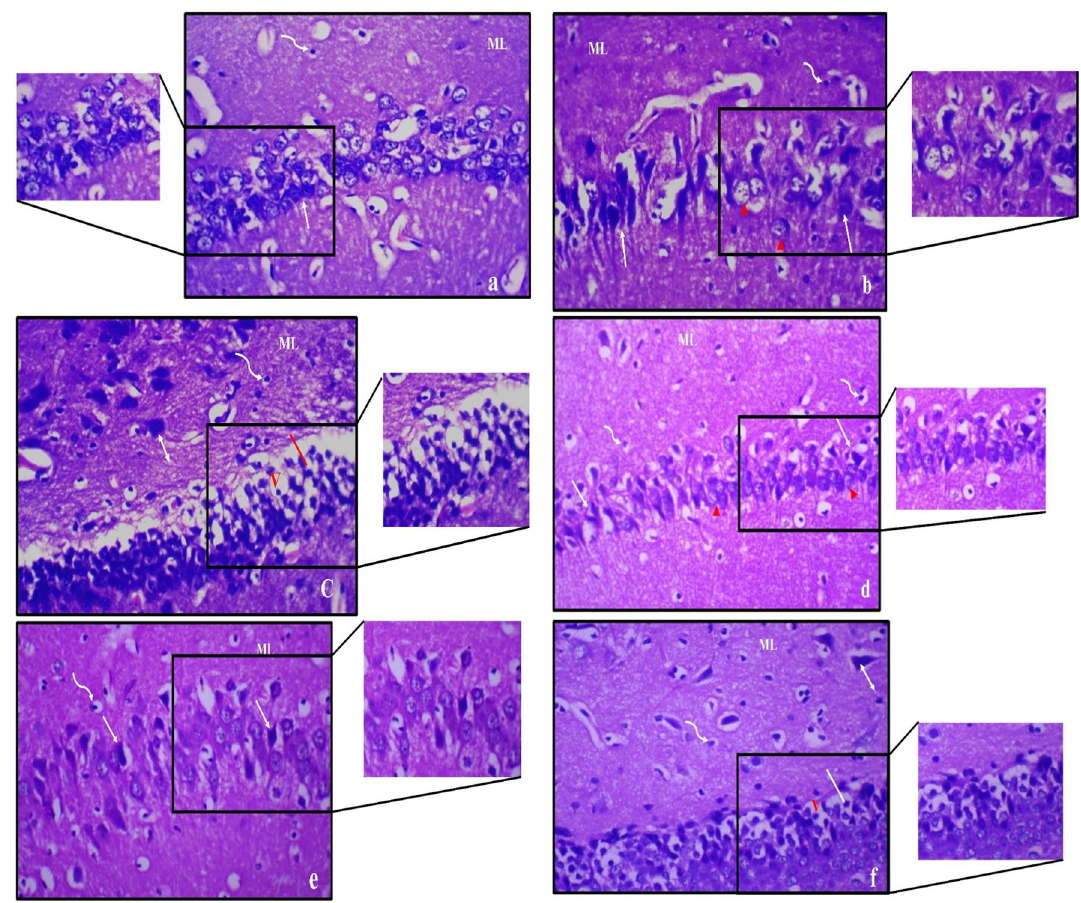
Figure 8. Photomicrograph of haematoxylin and eosin-stained sections from hippocampus of obese male rat ( a – c ) and obese female rats ( d – f ) treated with 15 mg of zinc showing partial improvement, where; ( a ) preservation of small pyramidal neurons with many apoptotic cells ( ↑ ); ( b ) marked apoptosis of large pyramidal neurons ( ↑ ) with few normal cells (right pointing triangle) and ( c ) decreased population of granular cells (|) with marked disorganization and vacuolation (V). Molecular layer (ML) mostly shows marked enlargement of neurons ( ↕ ) and many glial cells (wavy arrow); ( d ) preservation of small pyramidal cells (right pointing triangle) with many apoptotic cells ( ↑ ); ( e ) marked apoptosis of some large pyramidal cells ( ↑ ) and (f) d ecreased population of granular cells (|) with marked disorganization with less vacuolation (V). Molecular layer (ML) mostly shows marked enlargement of many neurons ( ↕ ) and many glial cells (wavy arrow) (H & E,